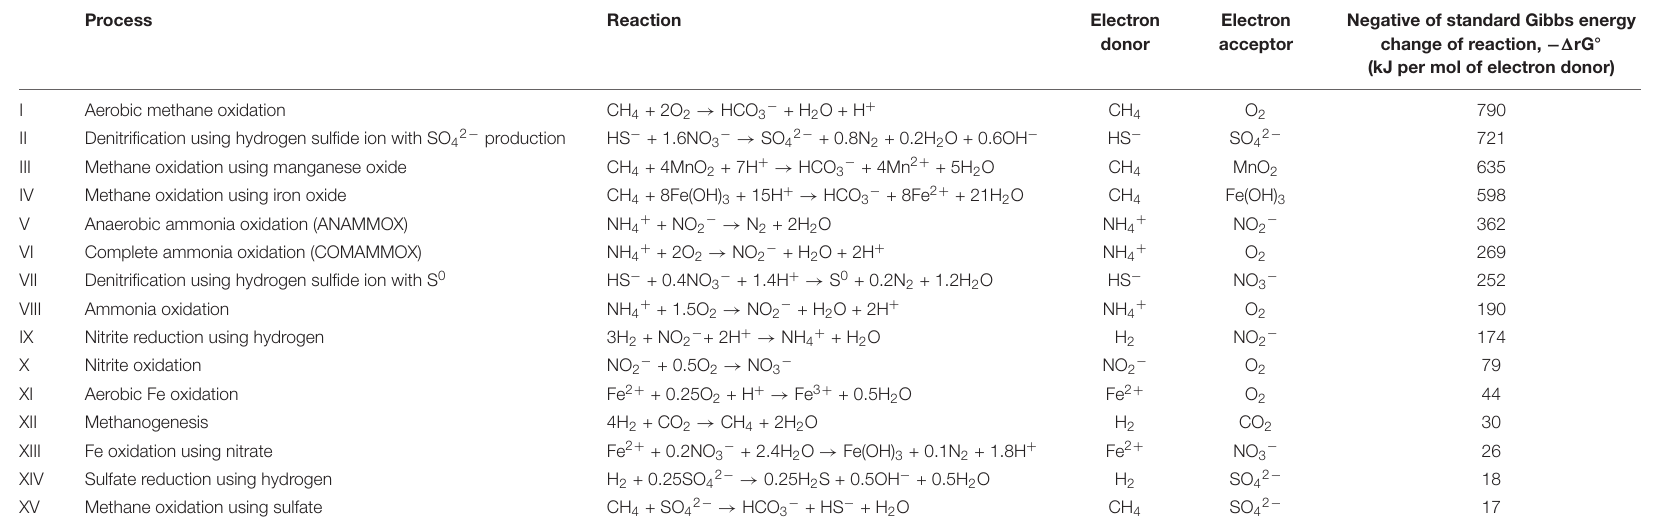
For the calculation of − (cid:49) r G ◦ , the values of (cid:49) f G ◦ at 25 ◦ C and 1 bar are cited from CHNOSZ package for R (http://chnosz.net). − (cid:49) r G ◦ for ferrihydrite was taken from Majzlan et al.